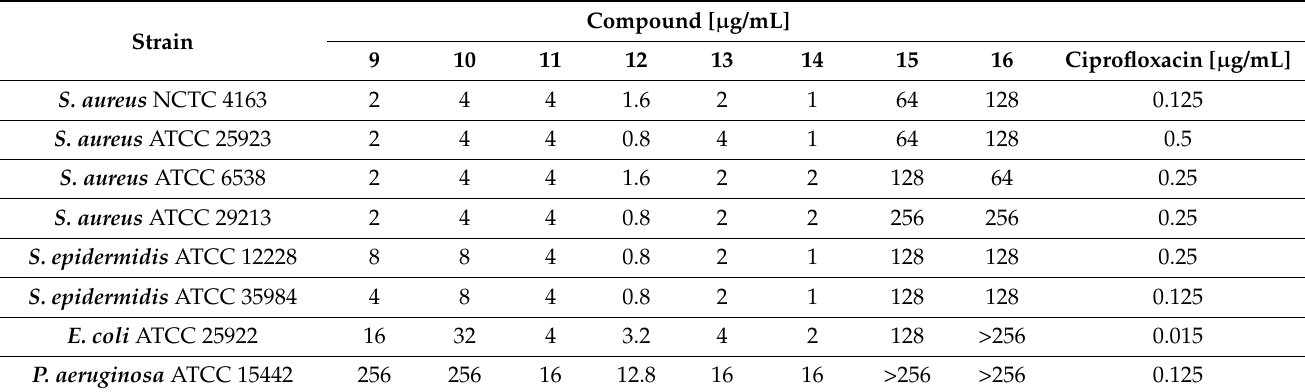
Table 3. Activity of Ciprofloxacin thymol derivatives against standard bacteria strains, expressed by minimal inhibitory concentrations ( µ